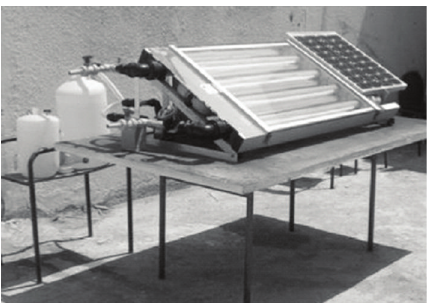
Figure 1: Final SOLWATER and AQUACAT water (solar pho- tocatalytic) disinfection system installed at Ecole Superieure de Technologie de Fez, Morroco